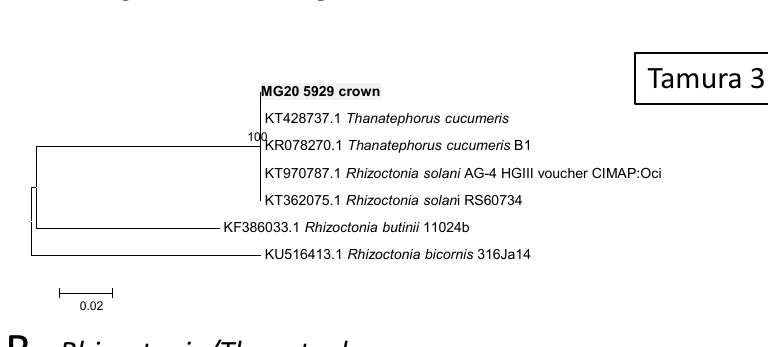
Figure 4. Phylograms of Molecular Operational Taxonomic Units. ( A ) Ustilago . ( B ) Rhizoctonia . The phylograms were generated with Maximum Likelihood analyses of the Internal Transcribed Spacer 2 region (used evolutionary model indicated). Confidence levels ≥ 80% (1000 replicate bootstrap analysis) are indicated on the branches. Sequence reads generated in this study are indicated with MG